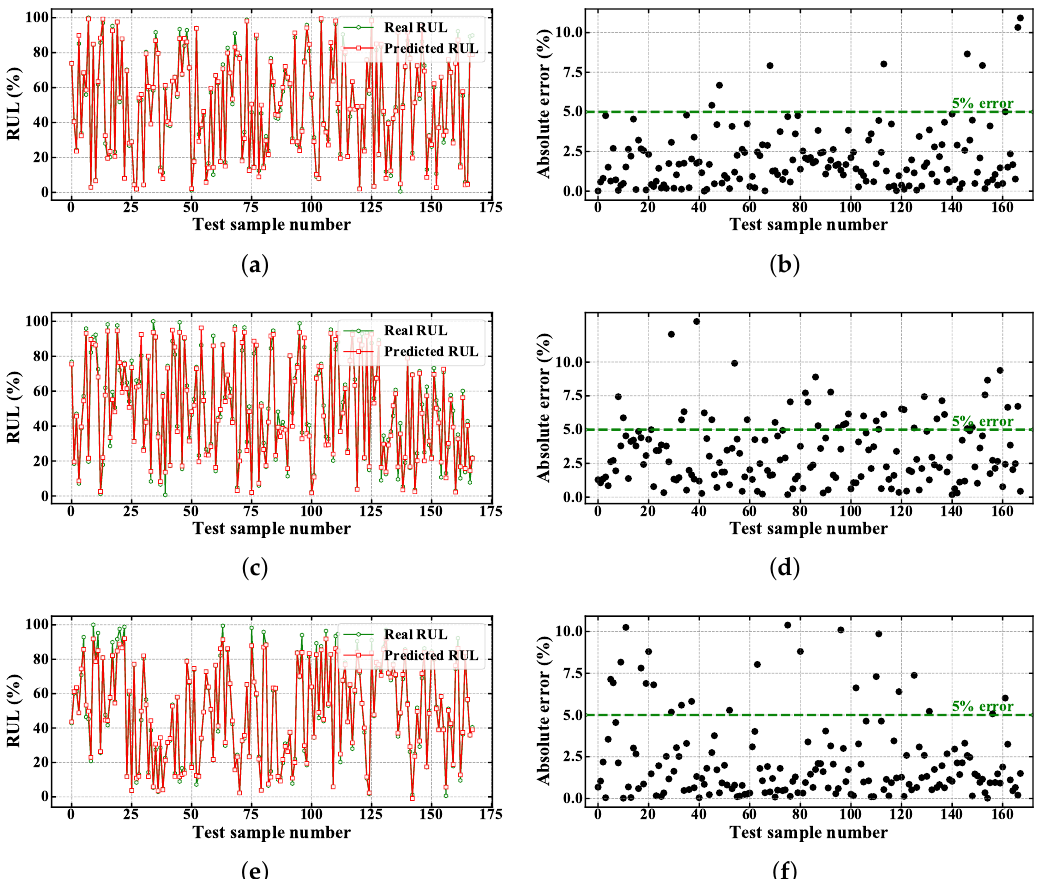
Figure 10. Results of experimental case 2. RUL prediction results and absolute errors when testing the PSO-GBDT method on an untrained battery: ( a , b ) Battery #5. ( c , d ) Battery #6. ( e , f ) Battery